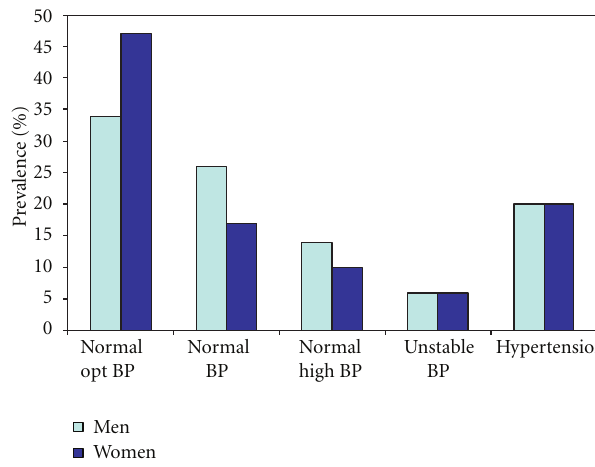
Figure 1: The figure illustrates the distribution (%) of blood pressure (BP) categories according to the 2007 ESH-ESC guidelines in men and women, respectively. The 2007 ESH-ESC blood pres- sure categories; normal optimal BP < 120/80mmHg, normal BP < 130/85mmHg, normal high BP < 140/90 mmHg. Hypertension was defined as known documented diagnosis for high blood pressure, or by three consecutive BP reading ≥ 140/90 mmHg (systolic and/or diastolic). When the BP exceeded these limits only once or twice, the BP was categorised as unstable.